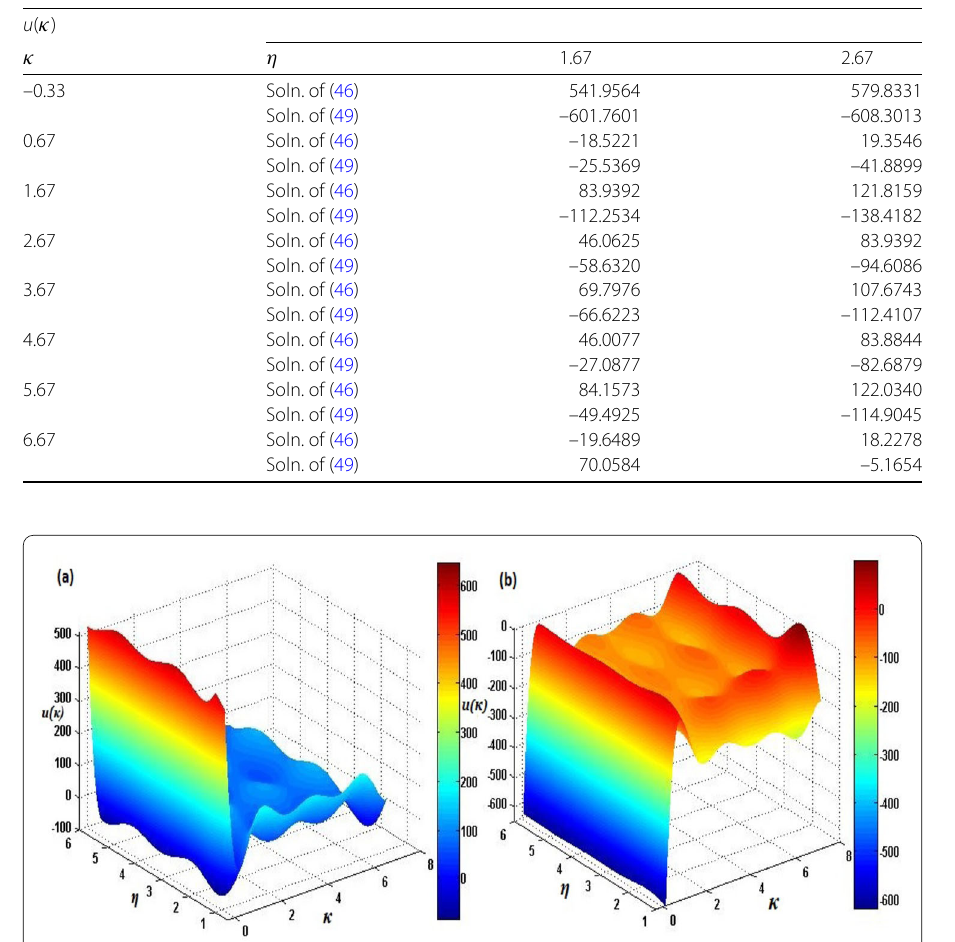
Figure 2 Surface corresponding to the graphs in Fig.